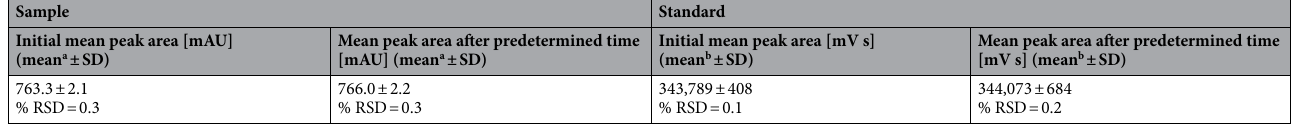
Table 6. Standard and sample solution stability. a Mean peak area of three injections. b Mean peak area of six injections.